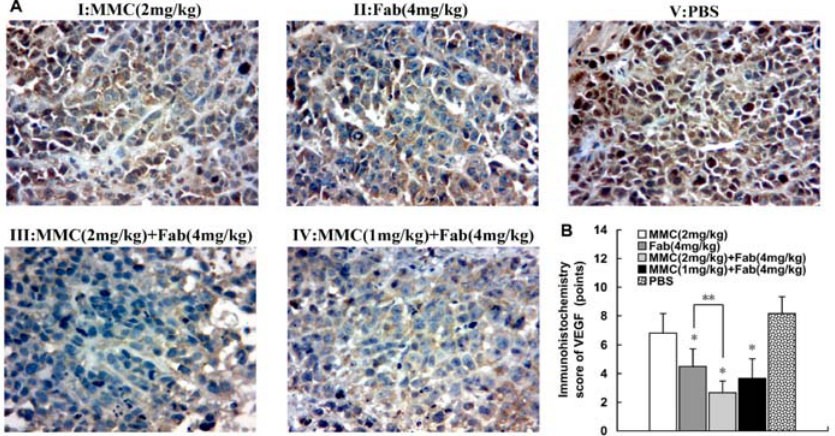
Figure 3. Immunihistochemical staining of vascular endothelial growth factor (VEGF) expression in tumor samples of five groups. A: Representative immunohistochemical staining of VEGF in tumor cells in different groups. Positive staining was observed as brown. I: MMC (2 mg/kg), moderately to strongly positive staining; II: Fab (4 mg/kg), moderately positive staining; III: MMC (2 mg/kg) + Fab (4 mg/kg), weakly positive staining; IV: MMC (1 mg/kg) + Fab (4 mg/kg), weakly to moderately positive staining; B: Comparison of immunohistochemistry score (IHS) of VEGF in xenograft tumor cells in different groups. V: PBS, strongly positive staining. Magnification: 400×. * P < 0.01 vs. group V; ** P < 0.05 vs. group